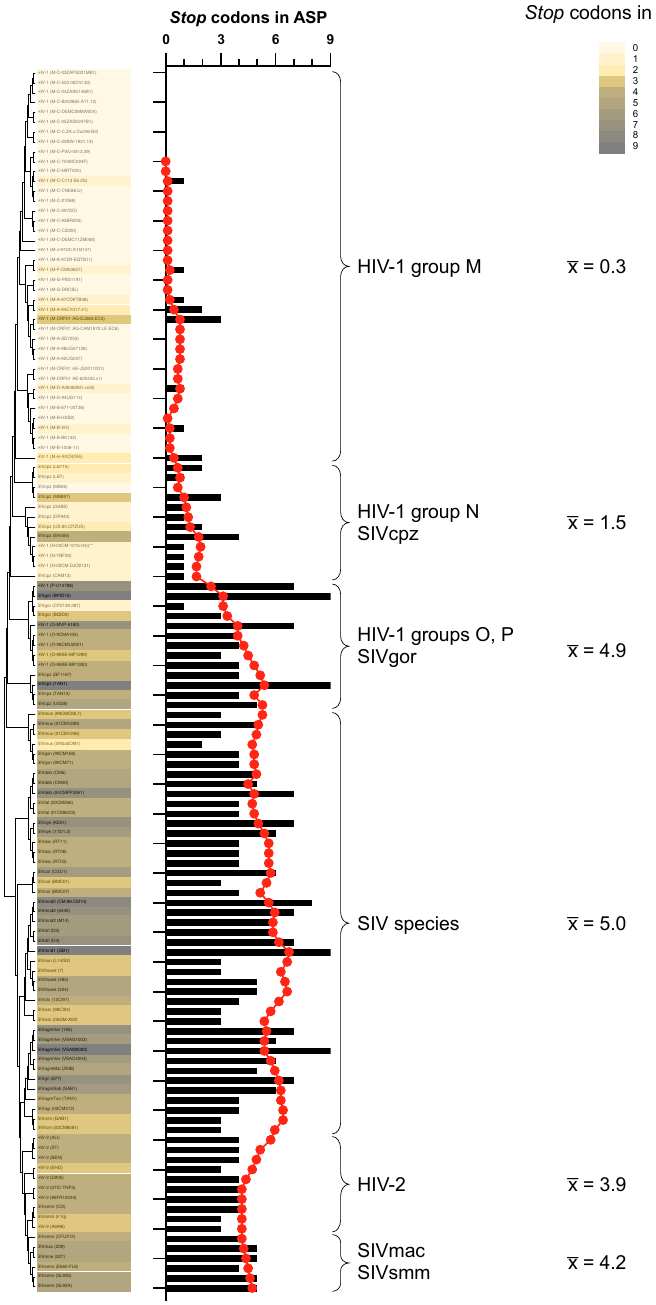
Figure 4. Phylogenetic analysis of internal stops in the asp ORF from primate lentiviruses. We assembled a dataset of 124 sequences spanning the region from the site of the canonical start codon to the site of the canonical stop codon. The dataset includes 40 HIV-1 strains of group M, and 84 HIV-1 strains of groups N, O, and P, HIV-2, and non-human primate lentiviruses (SIV). For group M HIV-1 strains, we included sequences from clades A, B, C, D, F, G, H, J, and K, and two circulating recombinant forms (CRF01_AE and CRF01_AG). The number of sequences representing each clade approximates the worldwide prevalence of the clade itself (except for F, H, J, and K; prevalence